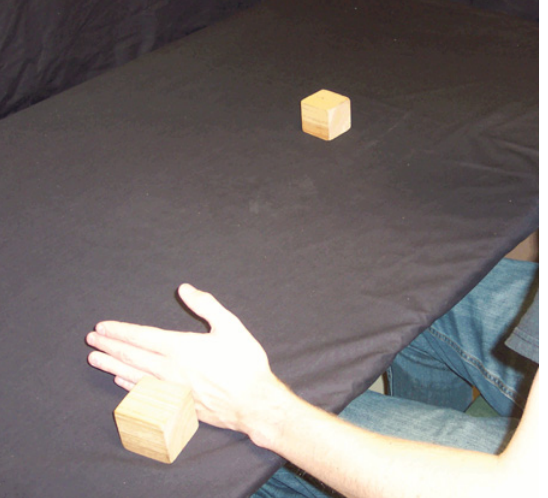
Fig 8. Reach and Brush Back condition. Participant reaches out and brushes the block along the table, back and to the side, using the back of the action